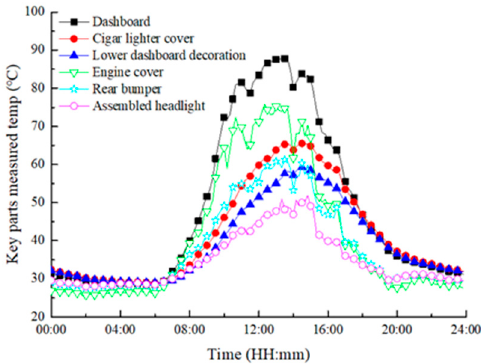
Figure 4. Dynamic variation on non-uniform measured temperature of key parts during day and